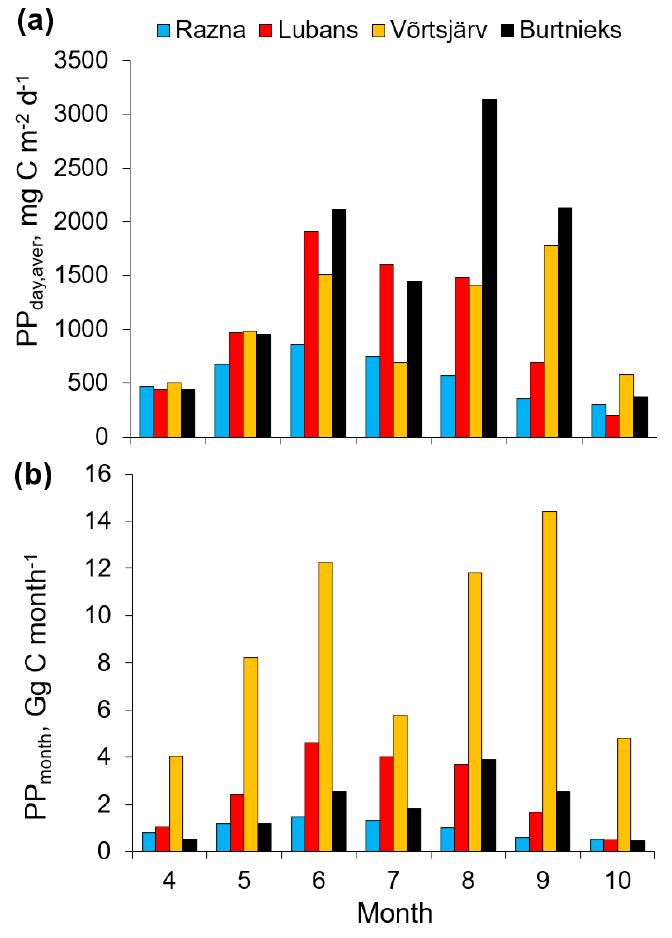
Figure 7. Monthly averages of daily average areal primary production (PP day,aver , mg C m − 2 d − 1 ) ( a ), and monthly sums of total daily primary production (PP month , Gg C month − 1 ) ( b ) in four studied lakes during 01 April 2018–31 October 2018.